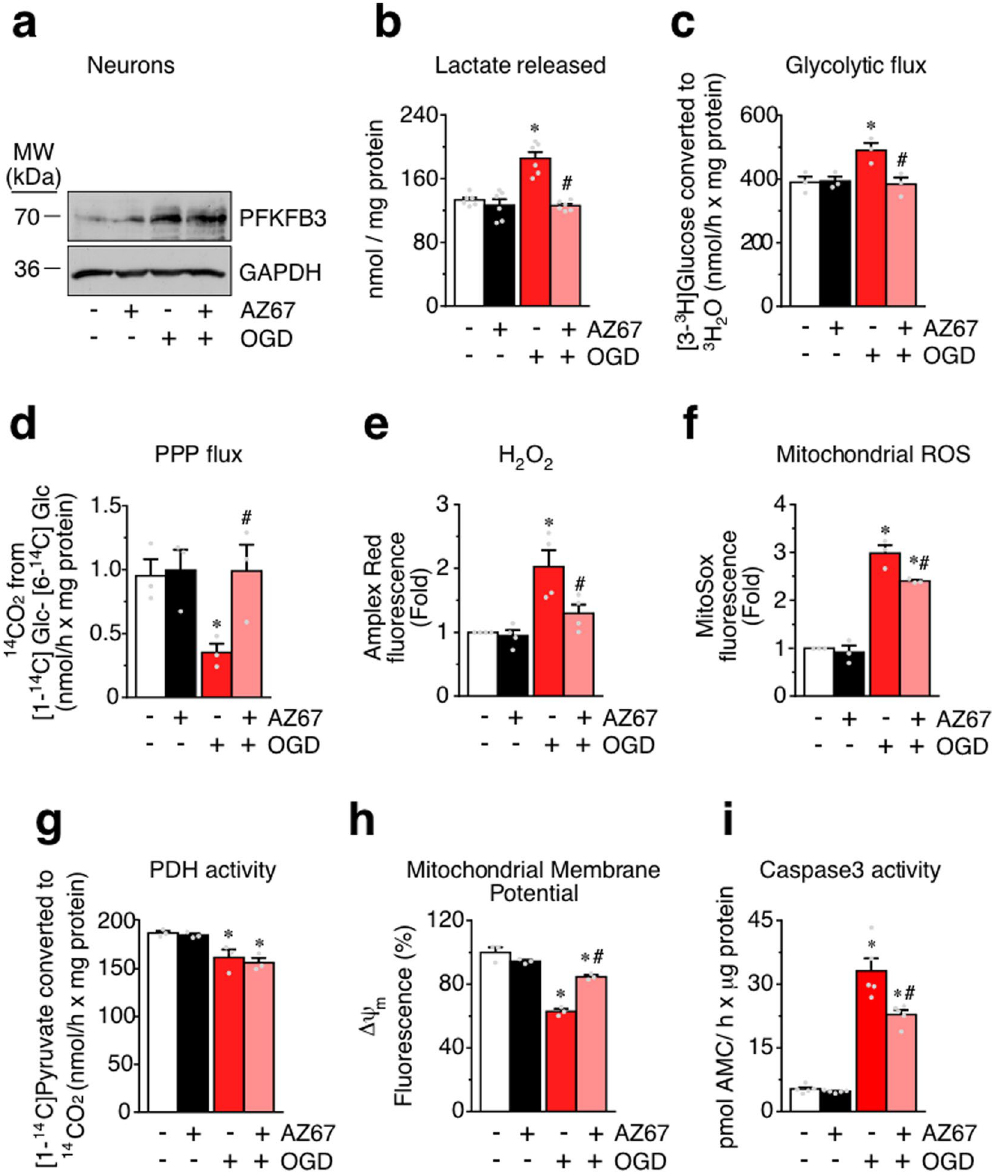
Figure 3. AZ67 prevents the metabolic switch from PPP to glycolysis, redox and mitochondrial stress, and apoptosis in an in vitro model of ischemia/reperfusion in primary neurons. (a) Western immunoblotting showing that the treatment of neurons with OGD (3 h) followed by reoxygenation (plus glucose) (4 h), stabilized PFKFB3 protein levels. Incubation of neurons with AZ67 (10 nM) during the 4 h of reoxygenation did not alter PFKFB3 protein levels. (b) Incubation of neurons with AZ67 for 4 h revealed no effect on lactate release. Treatment of neurons with OGD (3 h) followed by reoxygenation (plus glucose) (4 h) increased lactate released. Incubation of neurons with AZ67 (10 nM) during the 4 h of reoxygenation prevented the increase in lactate release. (c) Incubation of neurons with AZ67 for 4 h revealed no effect on the glycolytic flux, as assessed by the formation of 3 H 2 O from [3- 3 H]glucose. However, treatment of neurons with OGD (3 h) followed by reoxygenation (plus glucose) (4 h) increased the glycolytic flux. Incubation of neurons with AZ67 (10 nM) during the 4 h of reoxygenation prevented the increase in the glycolytic flux. (d) Incubation of neurons with AZ67 for 4 h revealed no effect on the pentose-phosphate pathway (PPP) flux, as assessed by the difference in the formation of 14 CO 2 from [1- 14 C]- and from [6- 14 C]glucose. However, treatment of neurons with OGD (3 h) followed by reoxygenation (plus glucose) (4 h) decreased the PPP flux. Incubation of neurons with AZ67 (10 nM) during the 4 h of reoxygenation prevented the decrease in the PPP flux. (e) Incubation of neurons with AZ67 for 4 h revealed no effect on H 2 O 2 release, as assessed by the fluorescence of AmplexRed. However, treatment of neurons with OGD (3 h) followed by reoxygenation (plus glucose) (4 h) increased H 2 O 2 release. Incubation of neurons with AZ67 (10 nM) during the 4 h of reoxygenation prevented the increase in H 2 O 2 release. (f) Incubation of neurons with AZ67 for 4 h revealed no effect on mitochondrial ROS formation, as assessed by MitoSox fluorescence by flow cytometry. However, treatment of neurons with OGD (3 h) followed by reoxygenation (plus glucose) (4 h) increased mitochondrial ROS. Incubation of neurons with